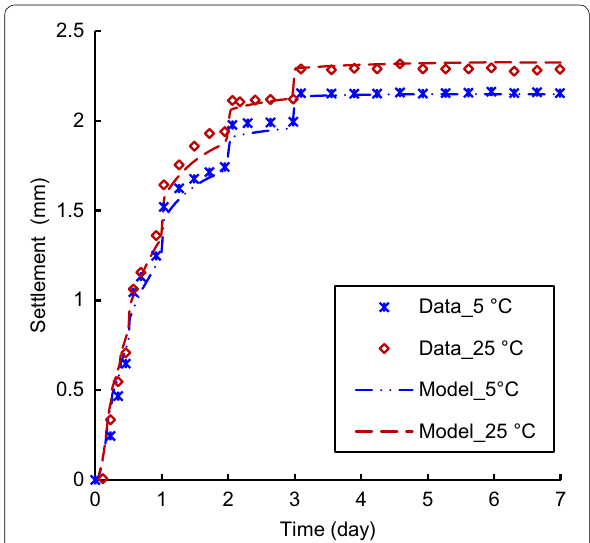
Fig. 3 Comparison of predicted results and experimental data for